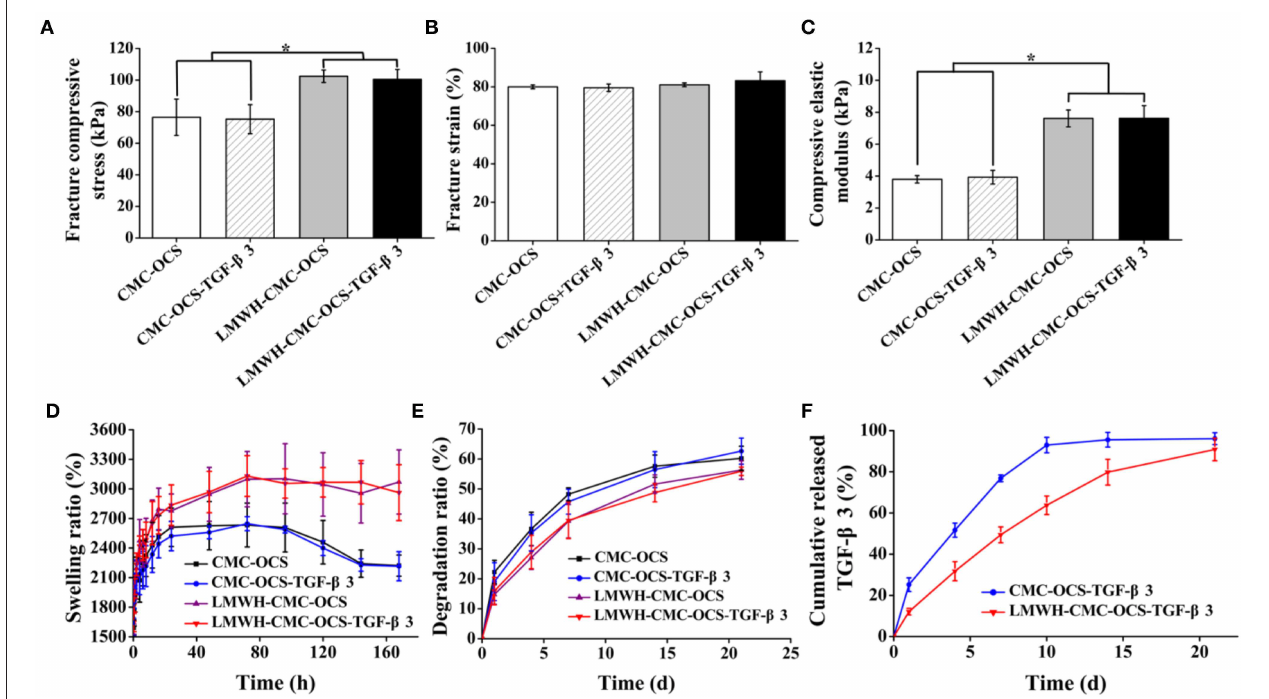
FIGURE 5 | (A) Fracture compressive stress ( n = 3, * P < 0.05), (B) fracture strain ( n = 3, P > 0.05), and (C) compressive elastic modulus ( n = 3, * P < 0.05) obtained by unconfined compressive mechanical tests. (D) Swelling kinetics of hydrogels in PBS at each time point ( n = 5). (E) In vitro degradation of hydrogels in PBS at each time point ( n = 5). (F) Cumulative release of TGF- β 3 from CMC-OCS-TGF- β 3 and LMWH-CMC-OCS-TGF- β 3 hydrogels after incubation for 1, 4, 7, 10, 14, and 21 days ( n = 5).